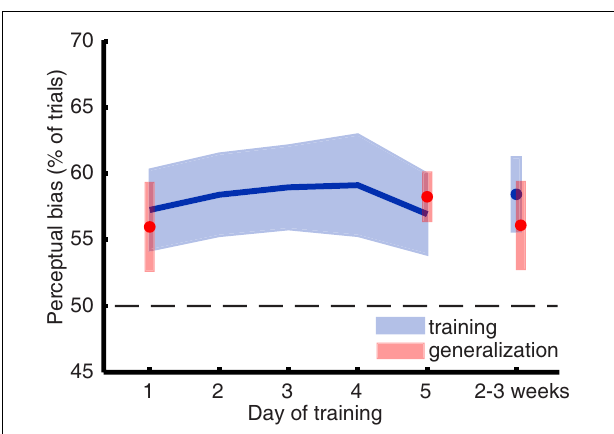
FIGURE 2 | Imagery biased perception during rivalry in favor of the previously imagined grating, but this perceptual bias did not significantly change over the course of a 5-day training. The blue line represents the mean training data, and the blue shaded regions represent ± 1 SEM.The parts of the plot depicted in red represent data from blocks where we tested training generalization to other